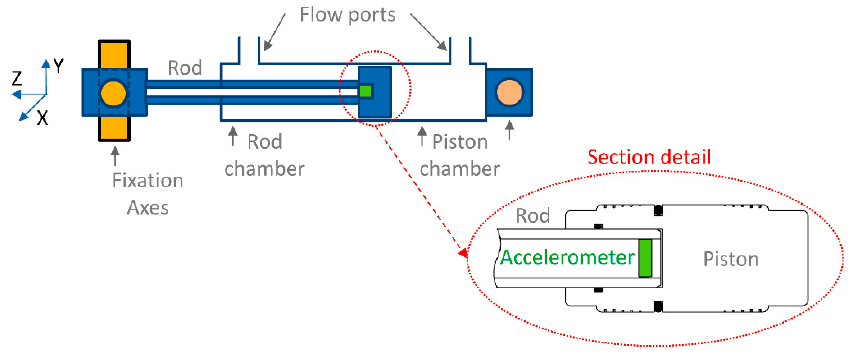
Figure 15. Hydraulic cylinder and accelerometer assembly schema.